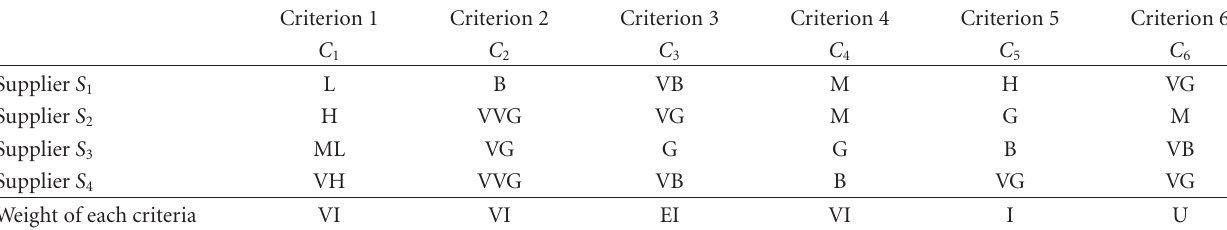
Table 6: Rating of the alternatives from decision maker 2 (DM 2 ).